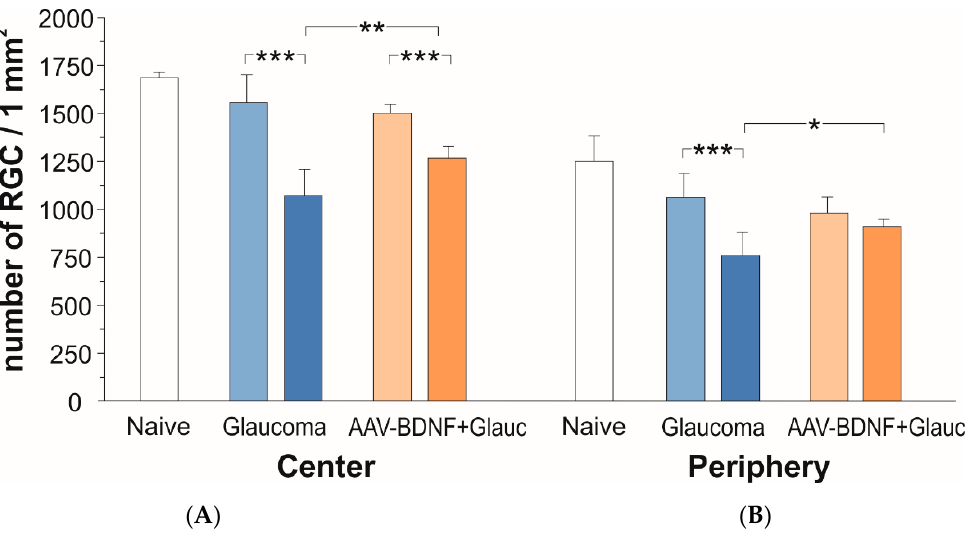
Figure 3. The effect of glaucoma (blue) and AAV2-BDNF treatment (orange) on the number of RGCs in central ( A ) and peripheral ( B ) fields of the retina six weeks after glaucoma induction. Dark color bars refer to the Right, glaucomatous eye. Light color bars mark the Left fellow eye. Data are shown as mean ± SD from 8 (glaucoma group) and 7 (AAV2-BDNF+ glaucoma group) rats. Two-way RM ANOVA, Sidak’s post-hoc test; *** p < 0.001, ** p < 0.01, * p < 0.05.